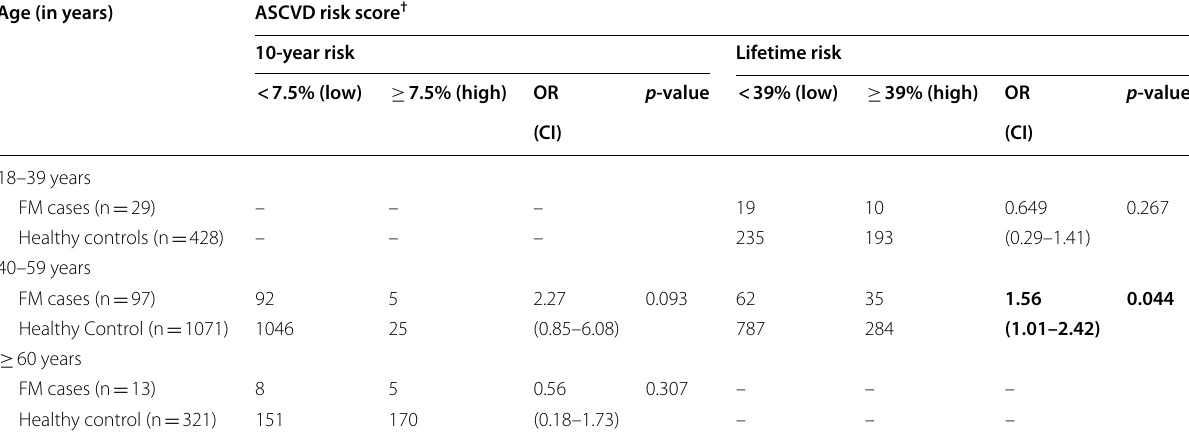
FM, fibromyalgia; ASCVD, Atherosclerotic cardiovascular disease; OR, odd’s ratio; CI, 95% confidence interval; Emboldened summary estimate is statistically significant at p <